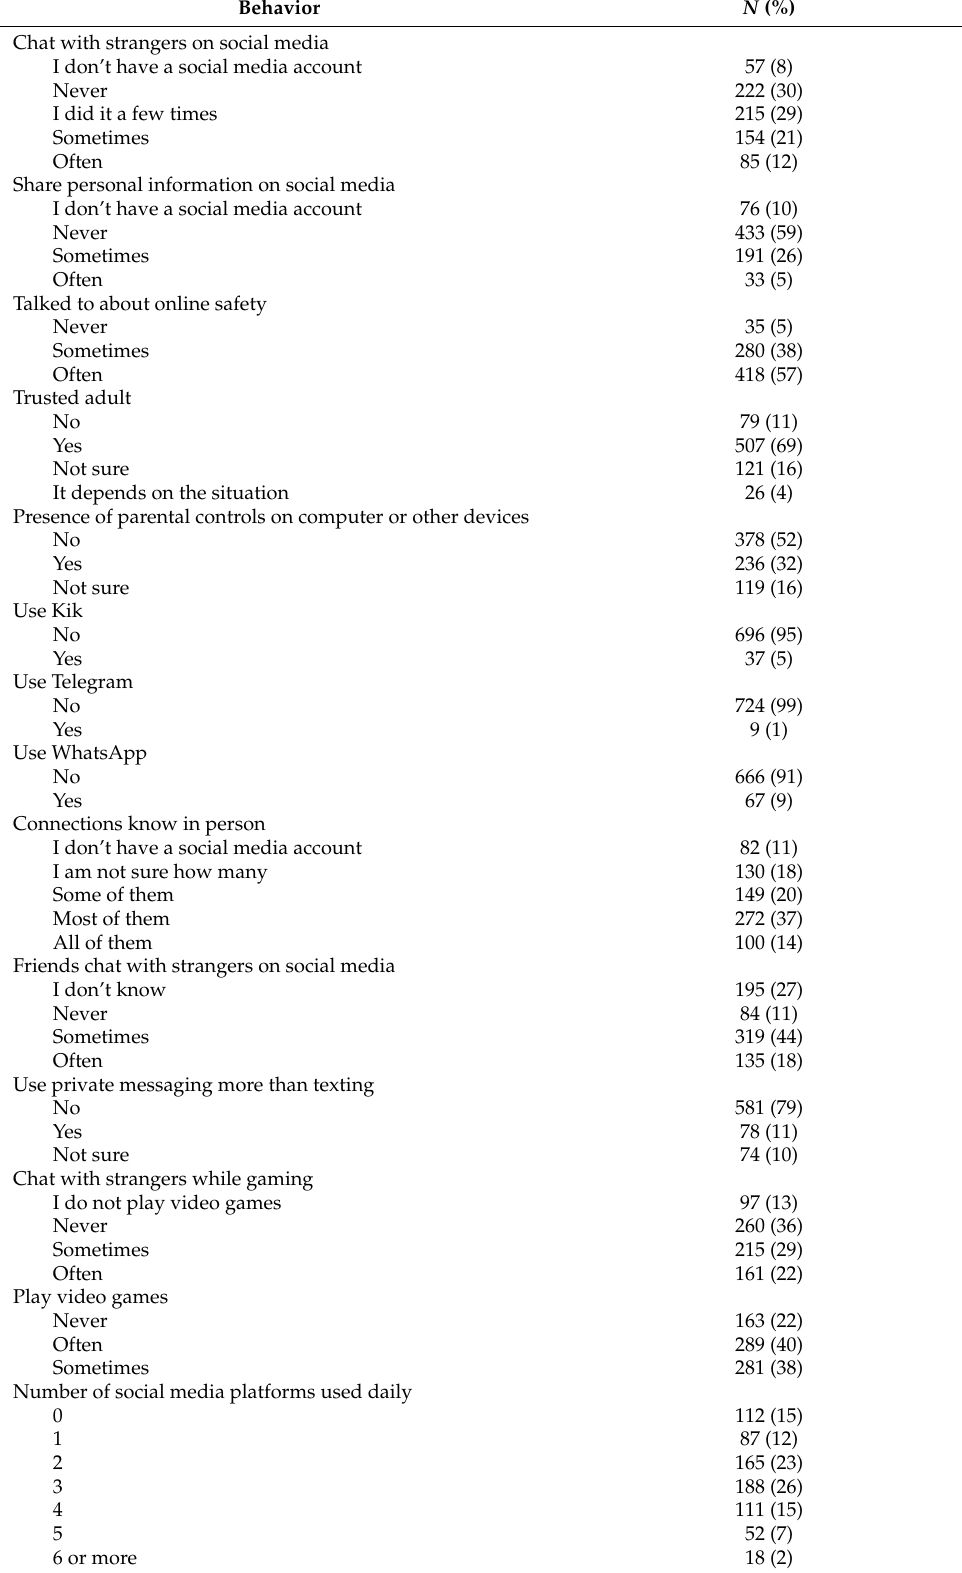
Table 1. Students’ Online